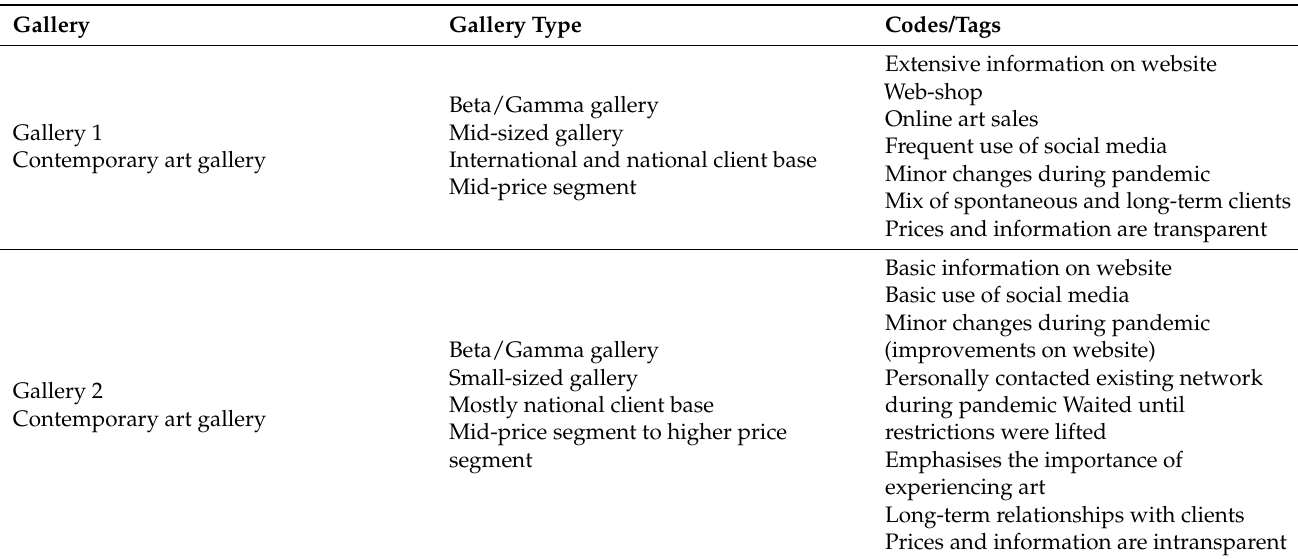
Table A1. List of Galleries, their Categorisation and Relevant